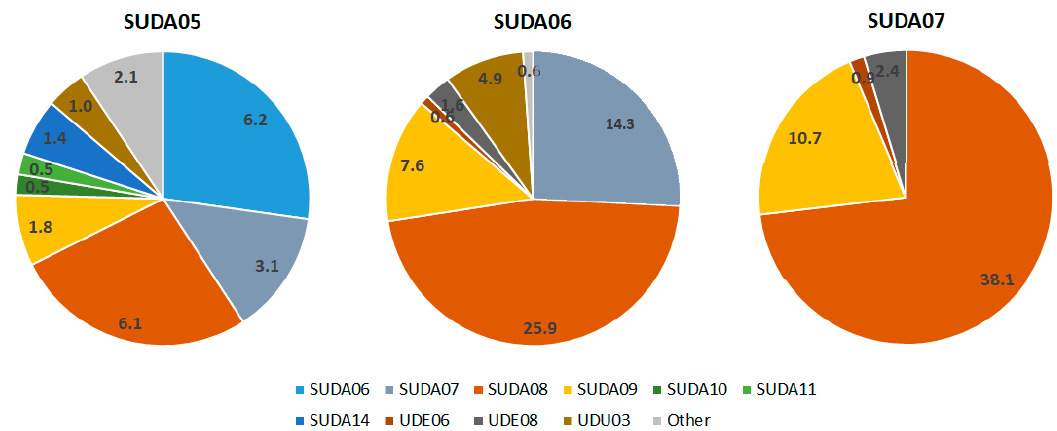
Figure 5. Destinations of return flow for three agricultural demand sites with high downstream reuse volumes (hm 3 / year). All downstream sites at which less than 0.5 hm 3 / year of return flow is reused are grouped as “Other”.